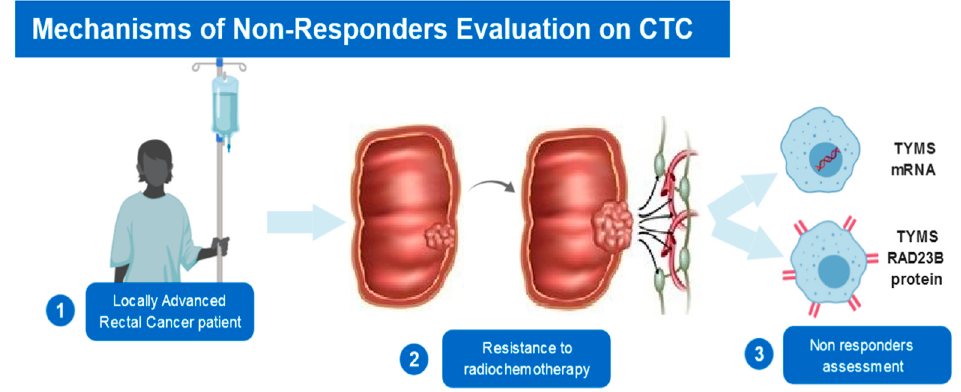
Figure 2. Scheme demonstrating both methodologies used to select responders and non-responders to neoadjuvant chemoradiotherapy: mRNA detected by CISH and protein expression detected by immunocytochemistry (ICC).